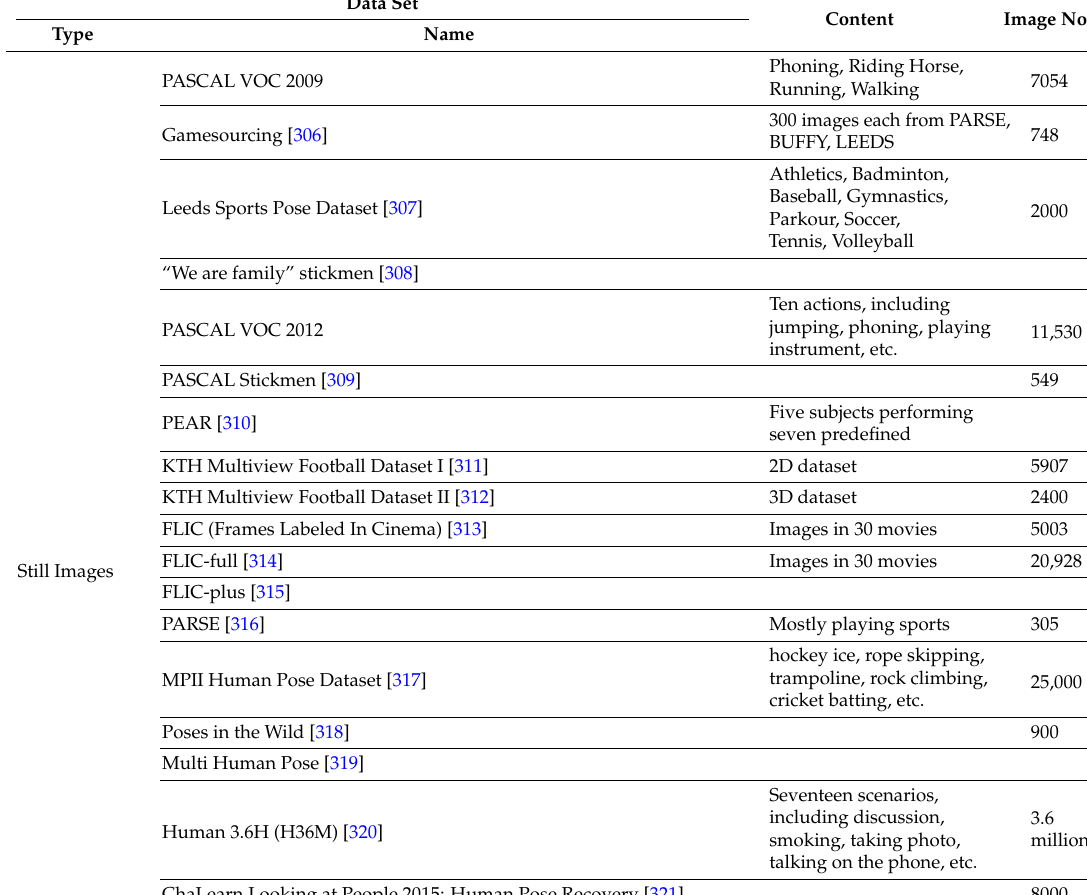
Table 2. Publicly available human pose estimation data